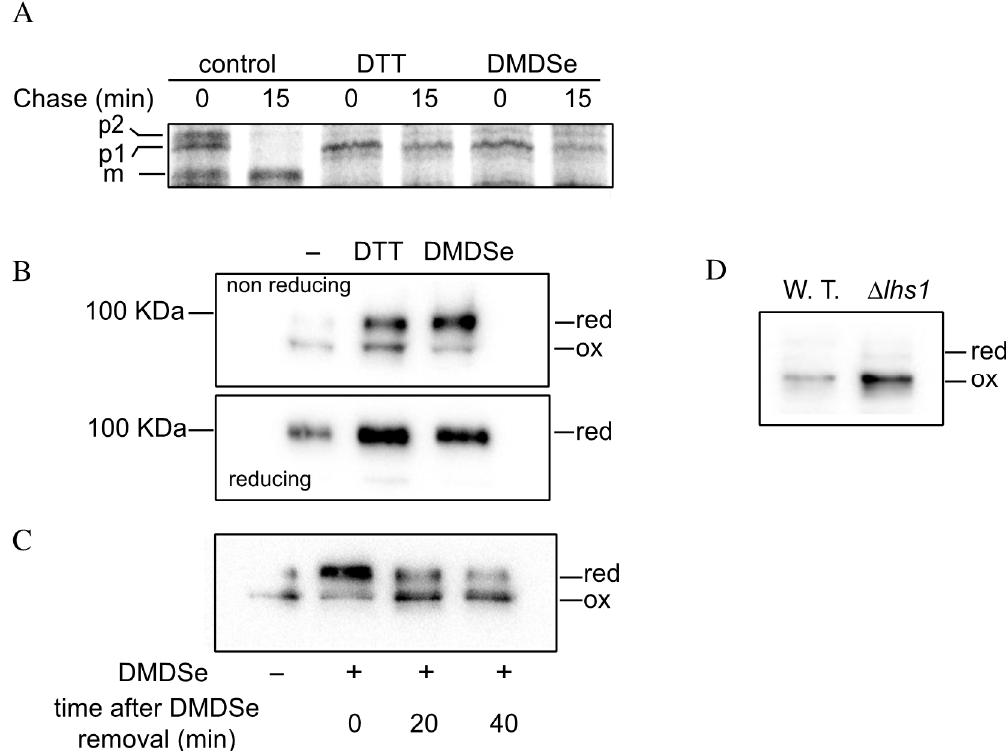
Figure 5. Disulfide formation in the ER is impaired by exposure to DMDSe. ( A ) Exponentially growing BY4741 incubated in SC + 100 µM methionine were exposed to nothing (control), 6 mM DTT or 100 µM DMDSe at 30 °C for 20 min before labeling for 10 min with the 35 S-Protein mix in a medium without methionine. Cells were harvested after 0 or 15 min of chase with cold methionine and cysteine. Total proteins were extracted and Cpy1p was immunoprecipitated using anti-carboxypeptidase Y antibodies. Immunoprecipitated samples were analyzed by SDS-PAGE (8%), and detected using a Typhoon phosphorimager. The position of the ER (p1) or Golgi (p2) propeptides and the matured protein (m) is indicated. ( B ) BY4741 cells carrying pAF84 (2 µ ERO1 - myc URA3 ) were grown in SD + 100 µM methionine. Cells were incubated in the absence or presence of 2 mM DTT or 100 µM DMDSe at 30 °C for 30 min. Free thiols were modified with iodoacetamide. Samples, containing equal amounts of proteins, were resolved by nonreducing SDS-PAGE (upper panel) or after the ad- dition of 20 mM DTT in the sample buffer (lower panel). Ero1p-myc was detected by Western blotting with anti-myc antibodies. ( C ) BY4741 cells carrying pAF84 were incubated in the absence (-) or presence (+) of 50 µM DMDSe for 30 min, after which the incubation was continued in fresh medium without DMDSe. The oxidation state of Ero1p was assessed as in ( B ) in cell extract harvested either immediately, 20 or 40 min after DMDSe removal. ( D ) The oxidation state of Ero1p was assessed as in ( B ), in BY4741 cells (W.T.) or in a ∆ lhs1 isogenic strain carrying pAF84.